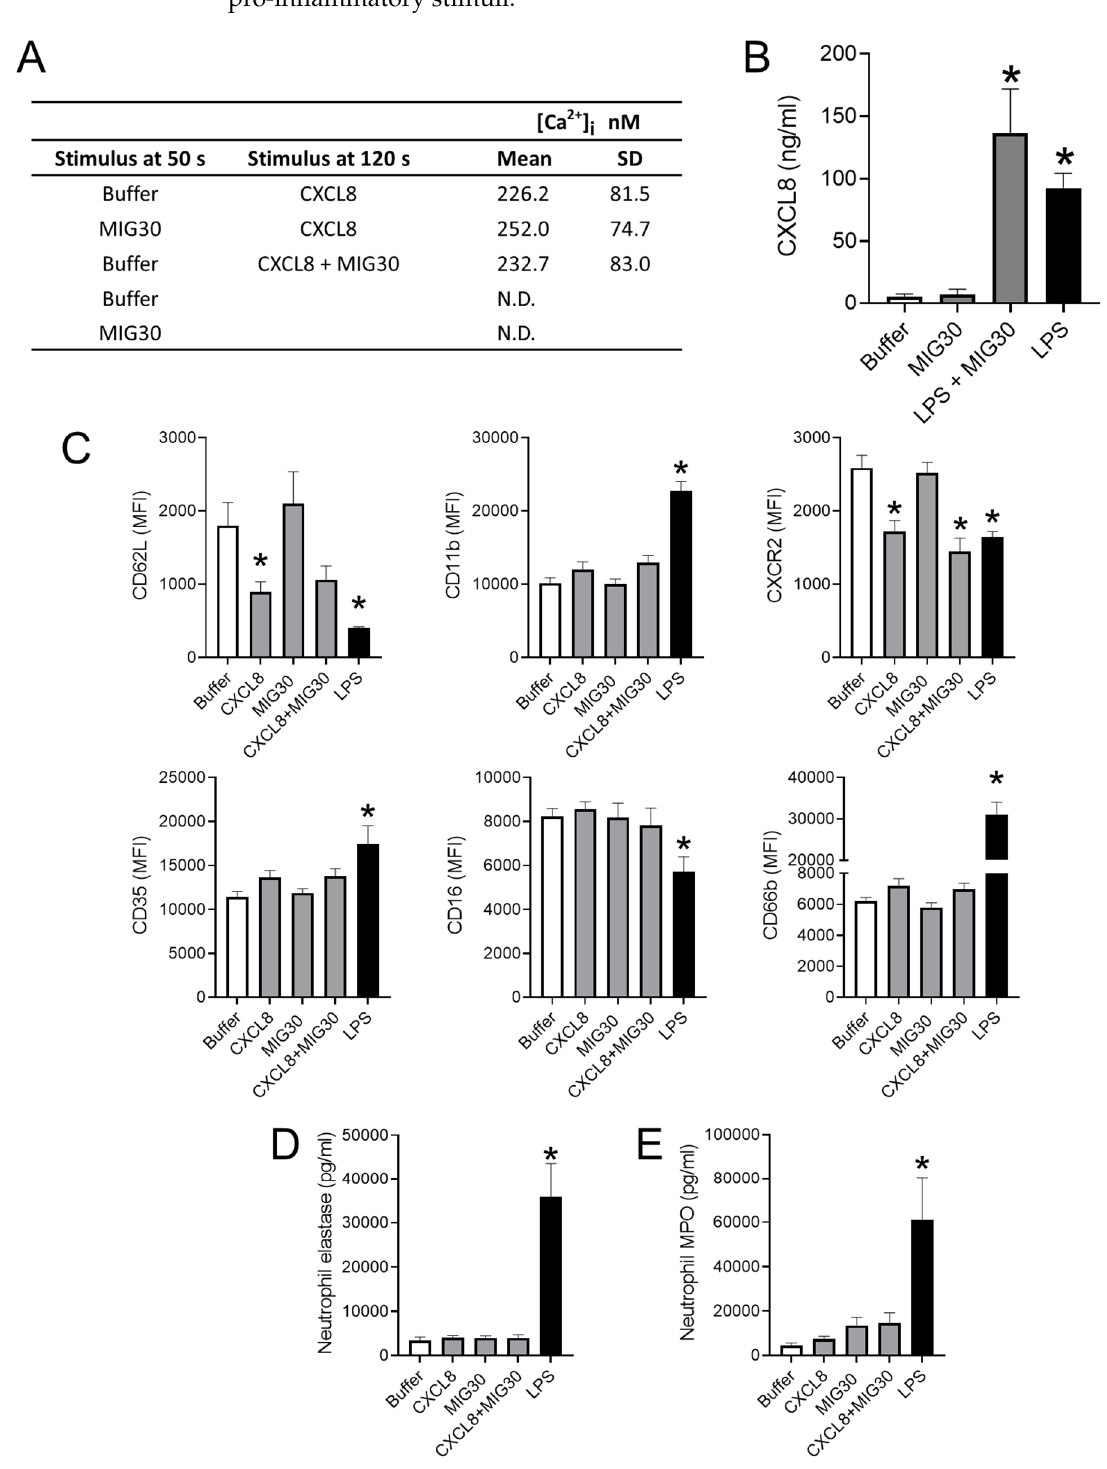
Figure 5. The MIG30 peptide does not affect the responsiveness or activation status of leukocytes towards stimuli. ( A ) Intracellular calcium signal ([Ca 2+ ] i in nM) in purified human neutrophils loaded with Fura ‐ 2/AM and stimulated with CXCL8 (10 ng/mL) and/or MIG30 (20 μ g/mL). Results shown are the mean ± SD increase of the [Ca 2+ ] i (nM) of 4 independent experiments. N.D. = Not detected. ( B ) Production of CXCL8 by human PBMCs stimulated with LPS (100 ng/mL), MIG30 (4 μ g/mL) or both stimuli combined. Cells were incubated for 24 h with the stimuli, and CXCL8 was measured in the supernatant by ELISA. ( C ) Flow cytometry analysis of purified human neutrophils stimulated for 1 h with LPS (5 μ g/mL), CXCL8 (10 ng/mL), MIG30 (20 μ g/mL) or a combination of CXCL8 and MIG30. The surface expression of CD62L, CD11b, CXCR2, CD35, CD16 and CD66b was